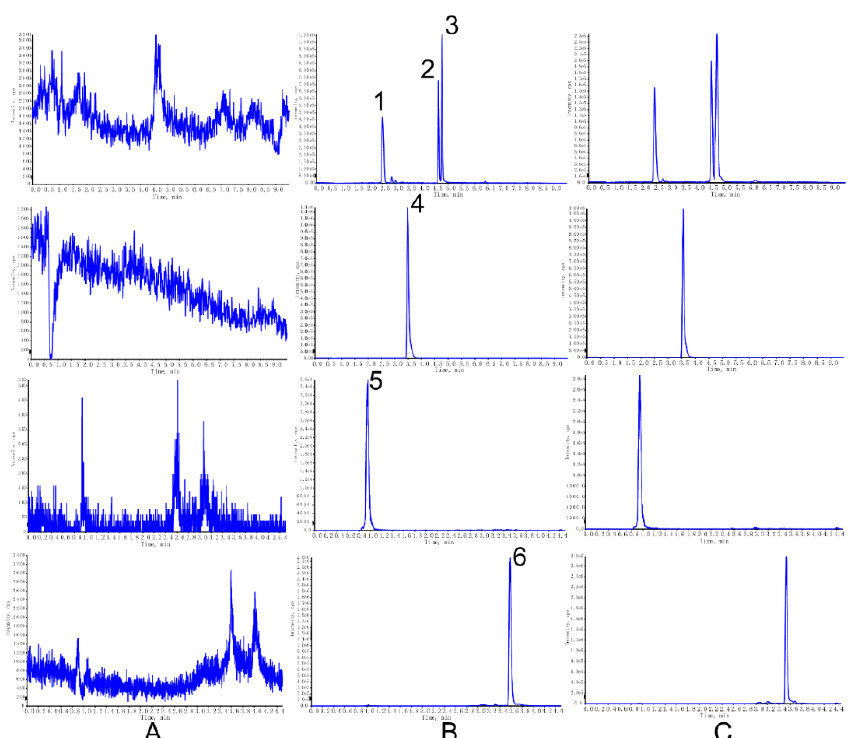
Figure 1. Representative multiple reaction monitoring (MRM) chromatograms of (1) Psoralenoside (PO), (2) Psoralen (P), (3) Isopsoralen (IP), (4) Escoparone, (5) Geniposide acid (GPA) and (6) Rhein in rat plasma. ( A ) Blank cell lysate, ( B ) cell lysate spiked with the standards and internal standard (IS), ( C ) sample collected from cells treated with standards.